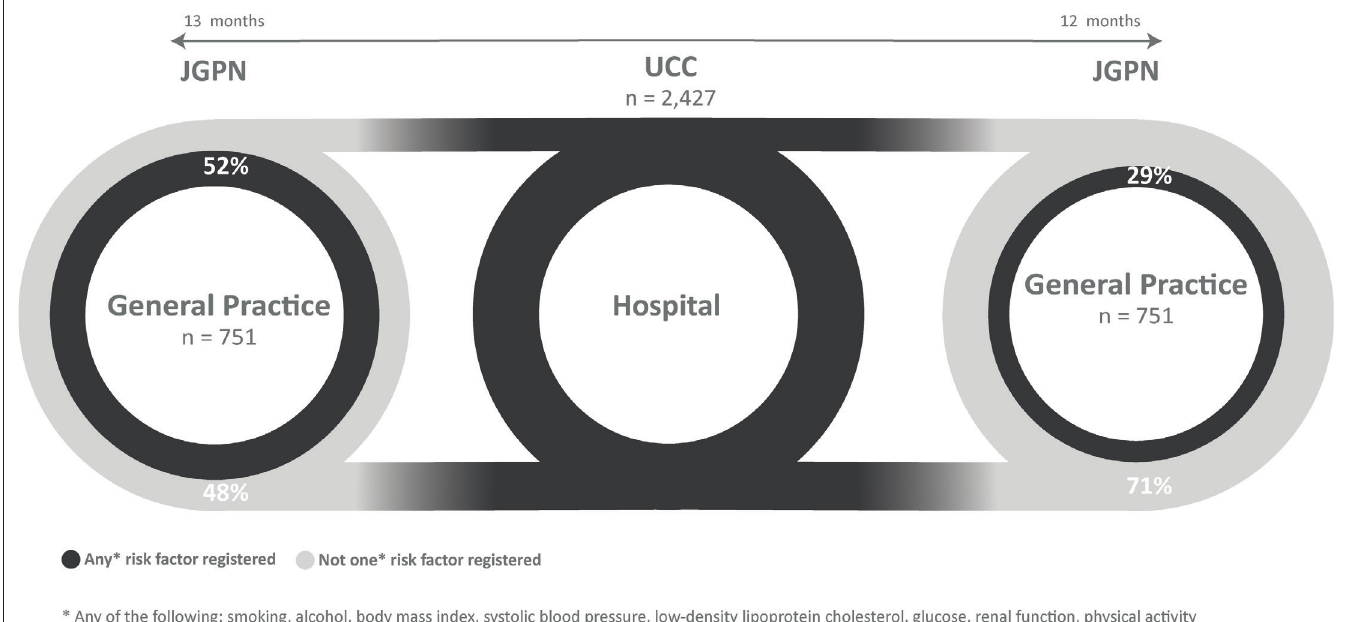
Figure 1 Flowchart of patient selection and risk factor assessment